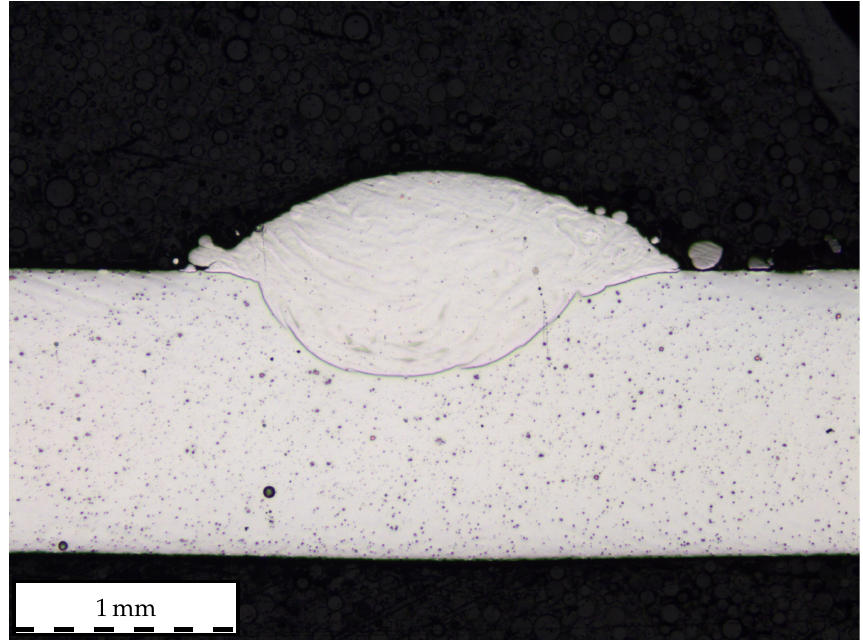
Figure 9. Example of obtained clad geometry during high-speed laser cladding of thin-sheet sub- strates. Parameters: d L 1200µm, P L = 2000W, v L = 90mms − 1 , ˙ m P = 24gmin − 1 , ˙ V S = 10Lmin − 1 , ≈ ˙ V 1 , z P = 5Lmin − f = 0mm, z D = 12mm, d K =